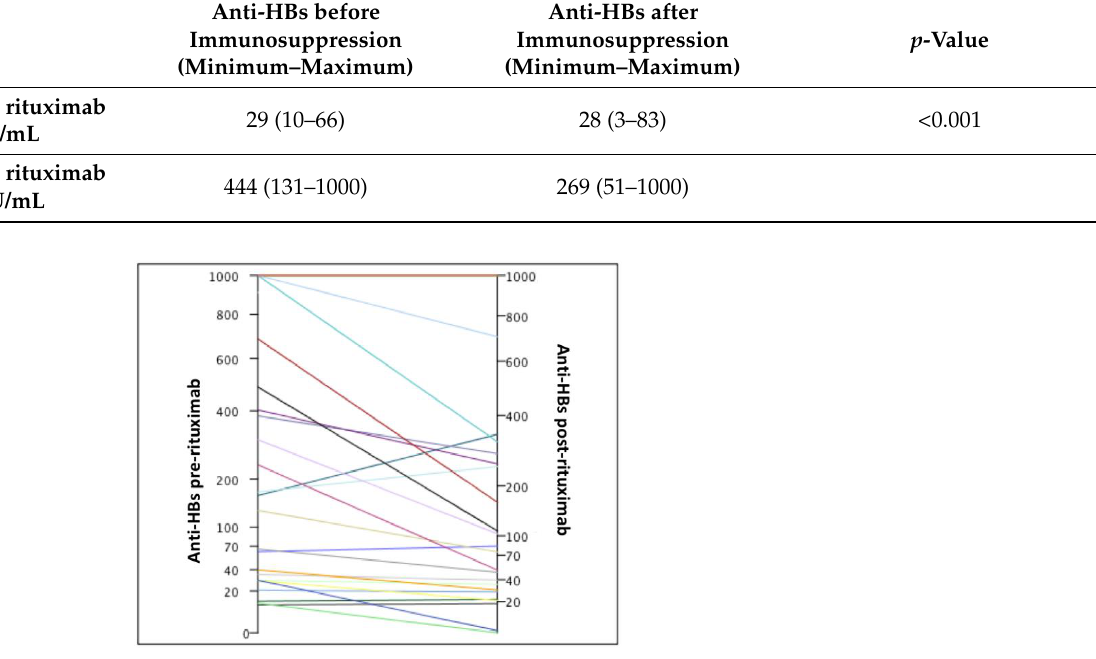
Figure 2. Individual values of anti-HBs before and after immunosuppression. Table 3. Median anti-HBs titers before and after rituximab therapy categorized by anti-HBs before immunosuppression.